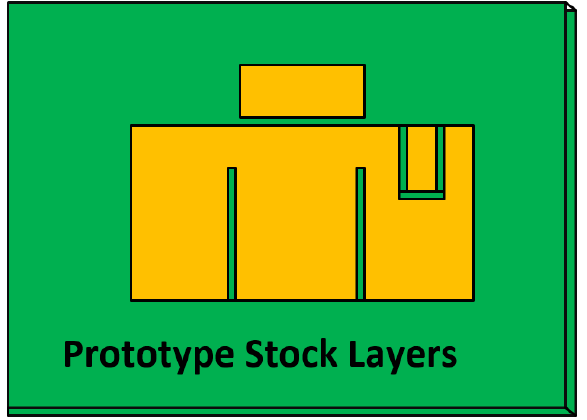
Figure 16. Multilayer prototype microfluidic E-shaped patch antenna.